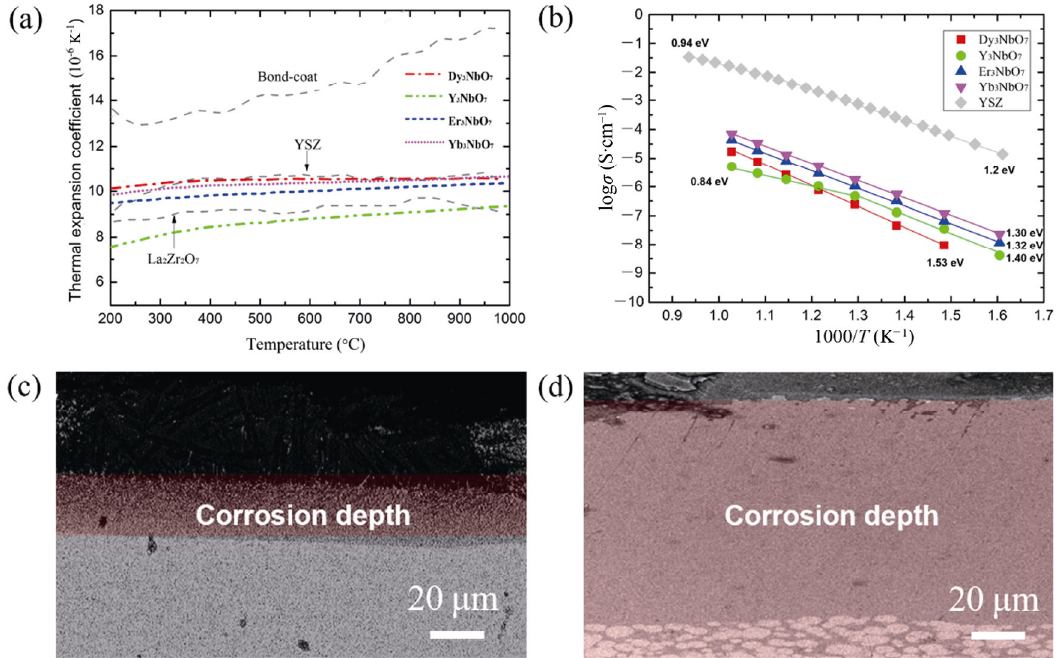
Fig. 9 Thermal, oxygen resistance, and CMAS resistance of RE 3 NbO 7 (RE = Dy, Y, Er, and Yb) compounds. (a) CTE, (b) Arrhenius plots for RE 3 NbO 7 ceramic electronic conductivity, and (c, d) CMAS corrosion depths of Dy 3 NbO 7 and YSZ. Reproduced with permission from Ref. [75], © The American Ceramic Society